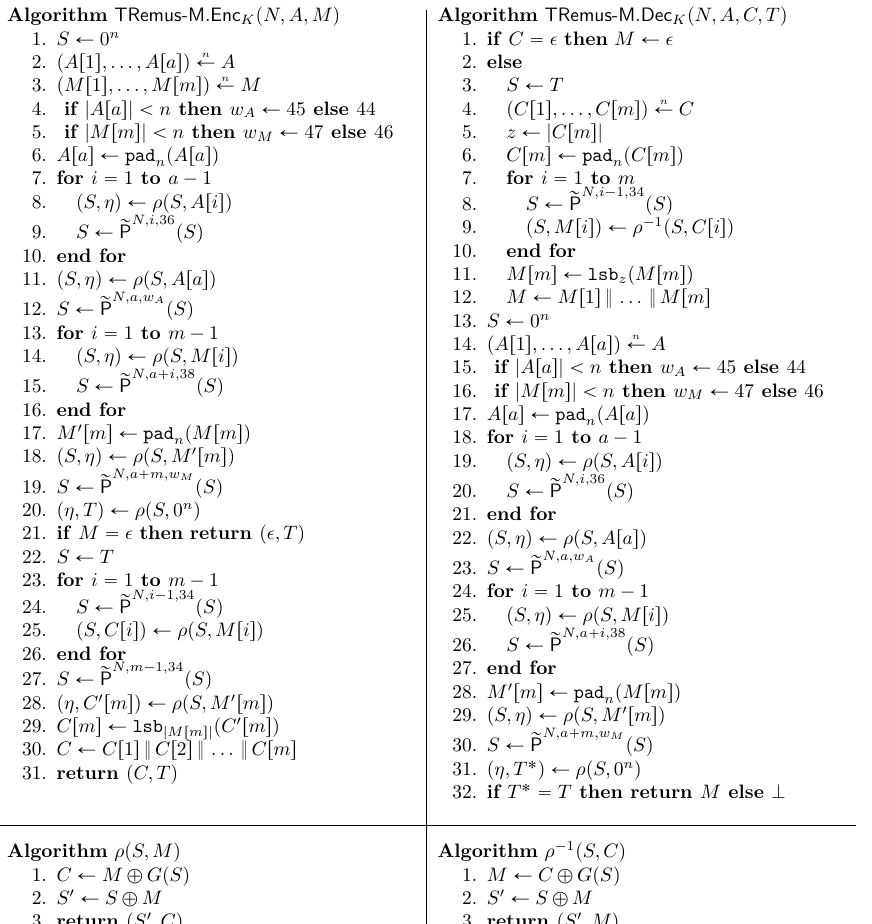
Figure 15: Encryption and decryption of TRemus-M , a TBC-based abstraction of Remus- r M . It uses a TBC P that has the same I/O as GICE1 . Remus - M 1 is used as a working